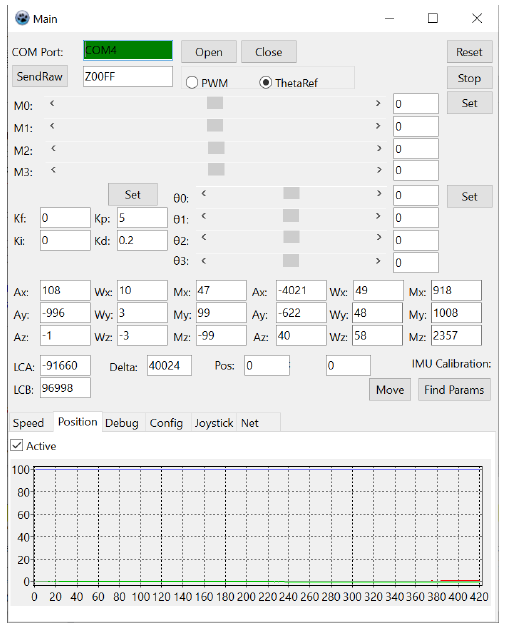
Figure 3. Graphical user interface of the PC